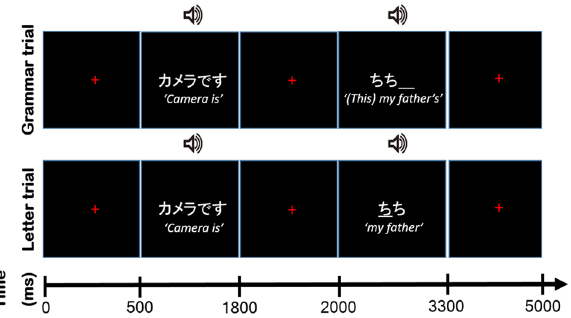
Figure 1. Sequence of events in the task. Each trial comprised two phases: preparation and production. In the preparation phase, the participant observed and listened to the predicate portion ( Camera is ). In the production phase, the subject (This) my father was presented. Two conditions were prepared in this phase: when an empty line was shown, the participant was required to utter a particle (Grammar condition). In this particular case, no (the possessive case) was the correct answer. When a Japanese letter was presented with an empty line, the participant was required to read out the letter (Letter condition). Activities during the task were modelled with boxcar functions for each phase, except for the rest condition. The English phrases in the figure is for explanatory purposes, and were not presented during the